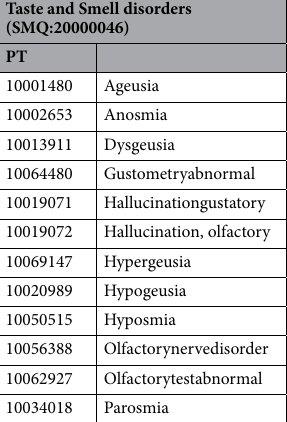
Table 6. Definition of taste and smell disorders. In the extraction by “Taste and smell disorders (SMQ: 2,000,046)”, 12 preferred terms (PTs) were included, including six PTs related to taste and six PTs related to